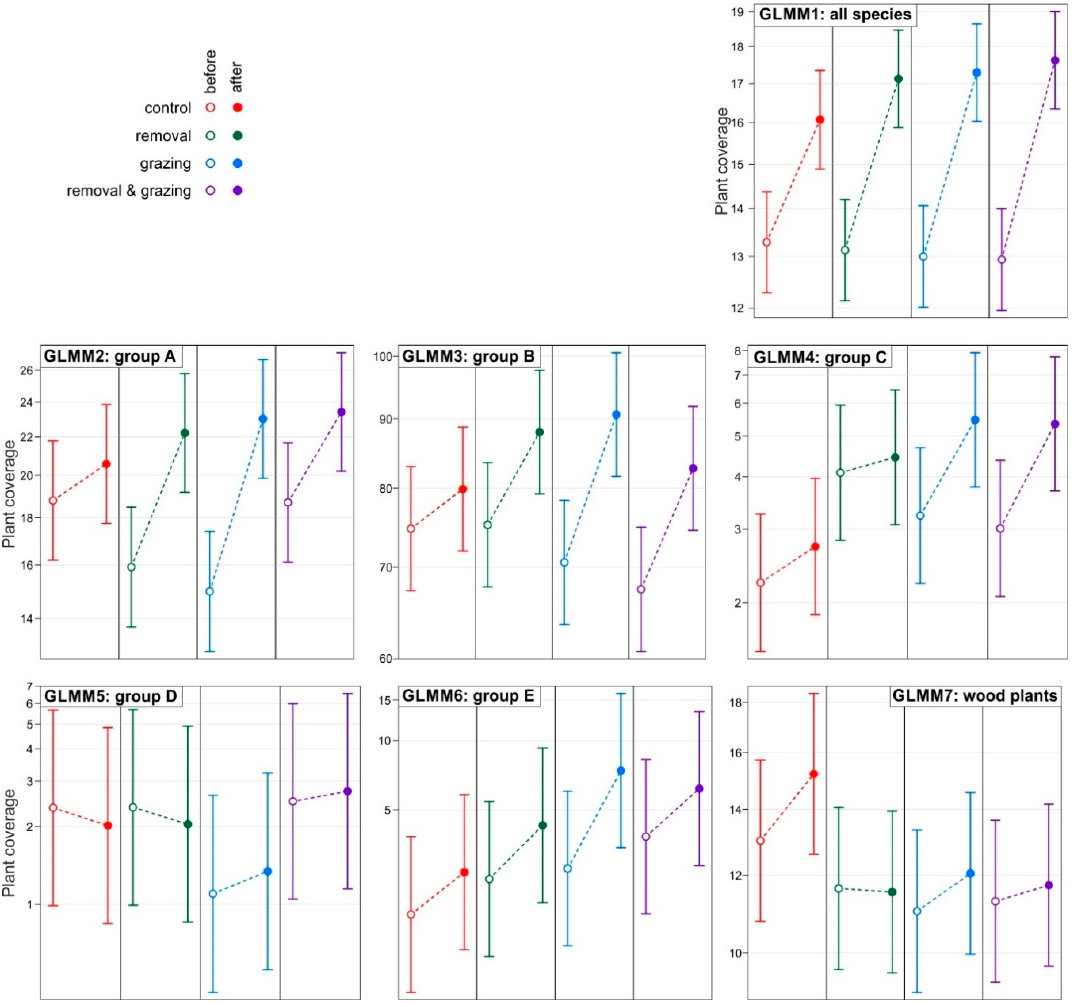
Figure 2. Coverage (and 95% confidence intervals) of all plant species and species belonging to studied ecological groups (all species, A—thermophilous oak forest species, B–deciduous forest species, C—meadow, xerothermic grassland and clearing species, D—wet-demanding and shadow-tolerant species, E—weeds and alien species, of herb layer in the studied oak forest, wood—trees and shrubs) in relation to treatment type (grazing and mechanical removal of understorey and their combination) over time, as predicted by models summarized in Table 1.